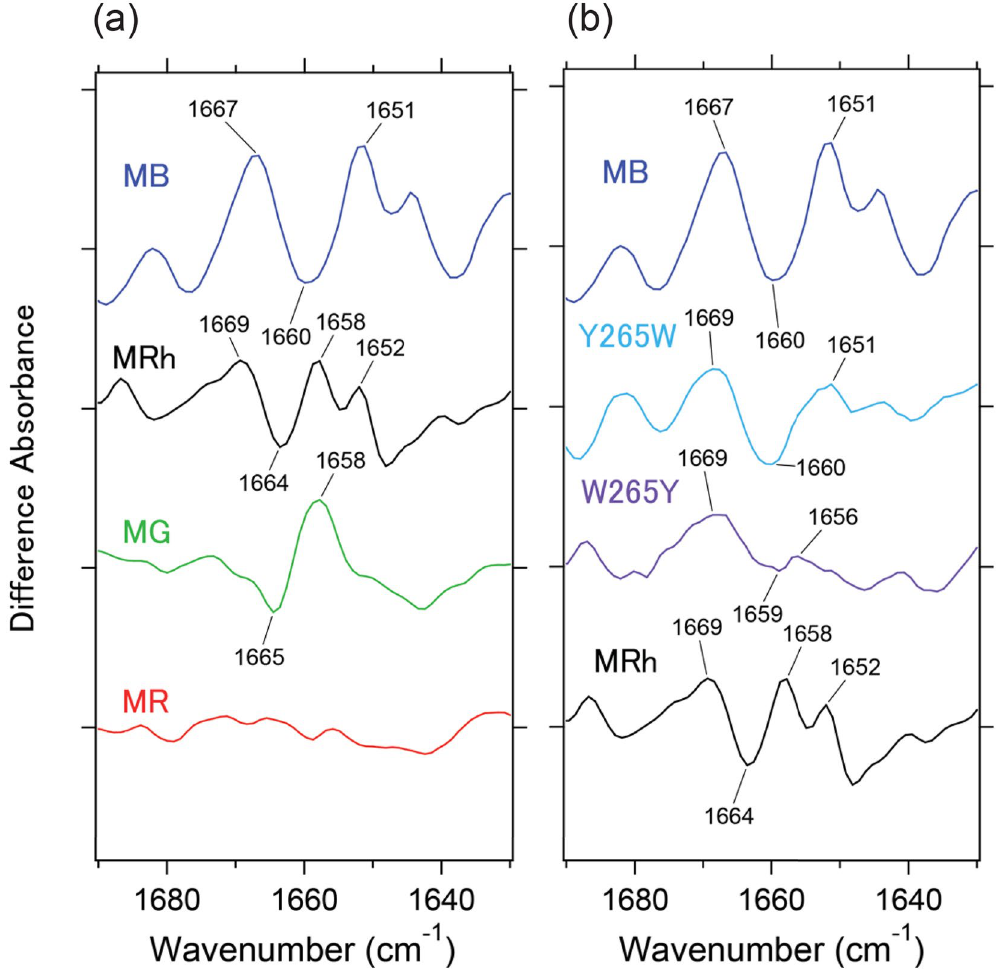
Figure 3. Spectral comparison of the mutant protein in the 1690–1630 cm − 1 region. ( a ) Expanded spectra from Fig. 1 in the 1690–1630 cm − 1 region. One division of the y-axis corresponds to 0.00055 absorbance units. ( b ) Light-induced all- trans minus 11- cis difference FTIR spectra of MB, MB-Y265W, MRh-W265Y and MRh in the 1000–800 cm − 1 region measured at 77 K in D 2 O. One division of the y-axis corresponds to 0.00055 absorbance